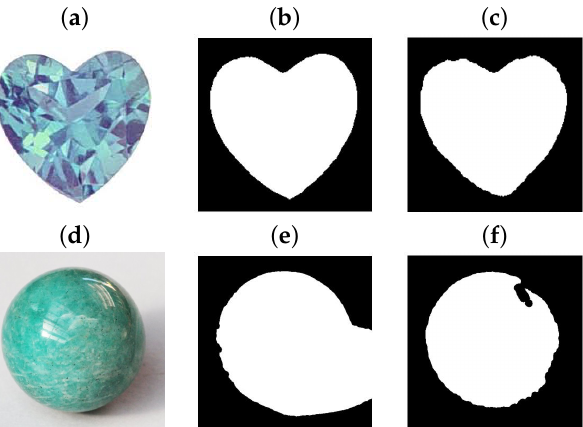
Figure 4. Illustration of the background segmentation for two representative images of Alexandrite ( top row ) and Amazonite ( bottom row ). ( a , d ) Original images. ( b , e ) Mask through intensity-based Otsu thresholding. ( c , f ) Mask through Otsu thresholding based on the Saturation channel of the HSV space. It should be noted that the purely intensity-based mask is less accurate than the Saturation- based